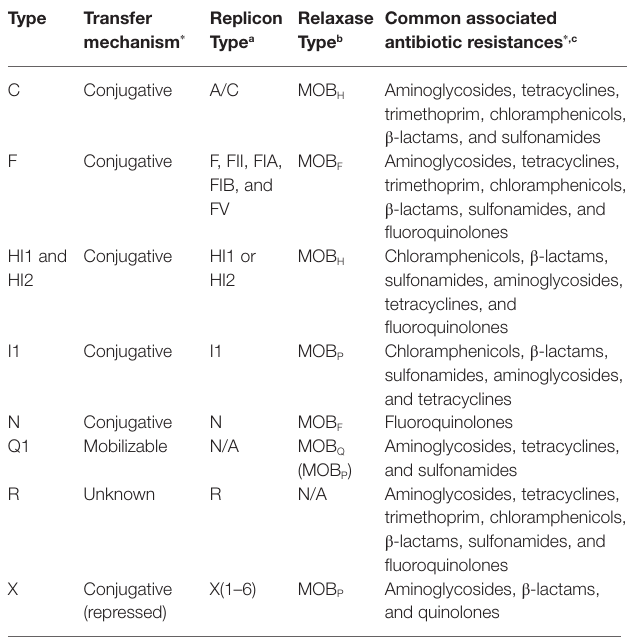
TABLE 1 | Summary of features of transferable plasmids associated with Salmonella enterica